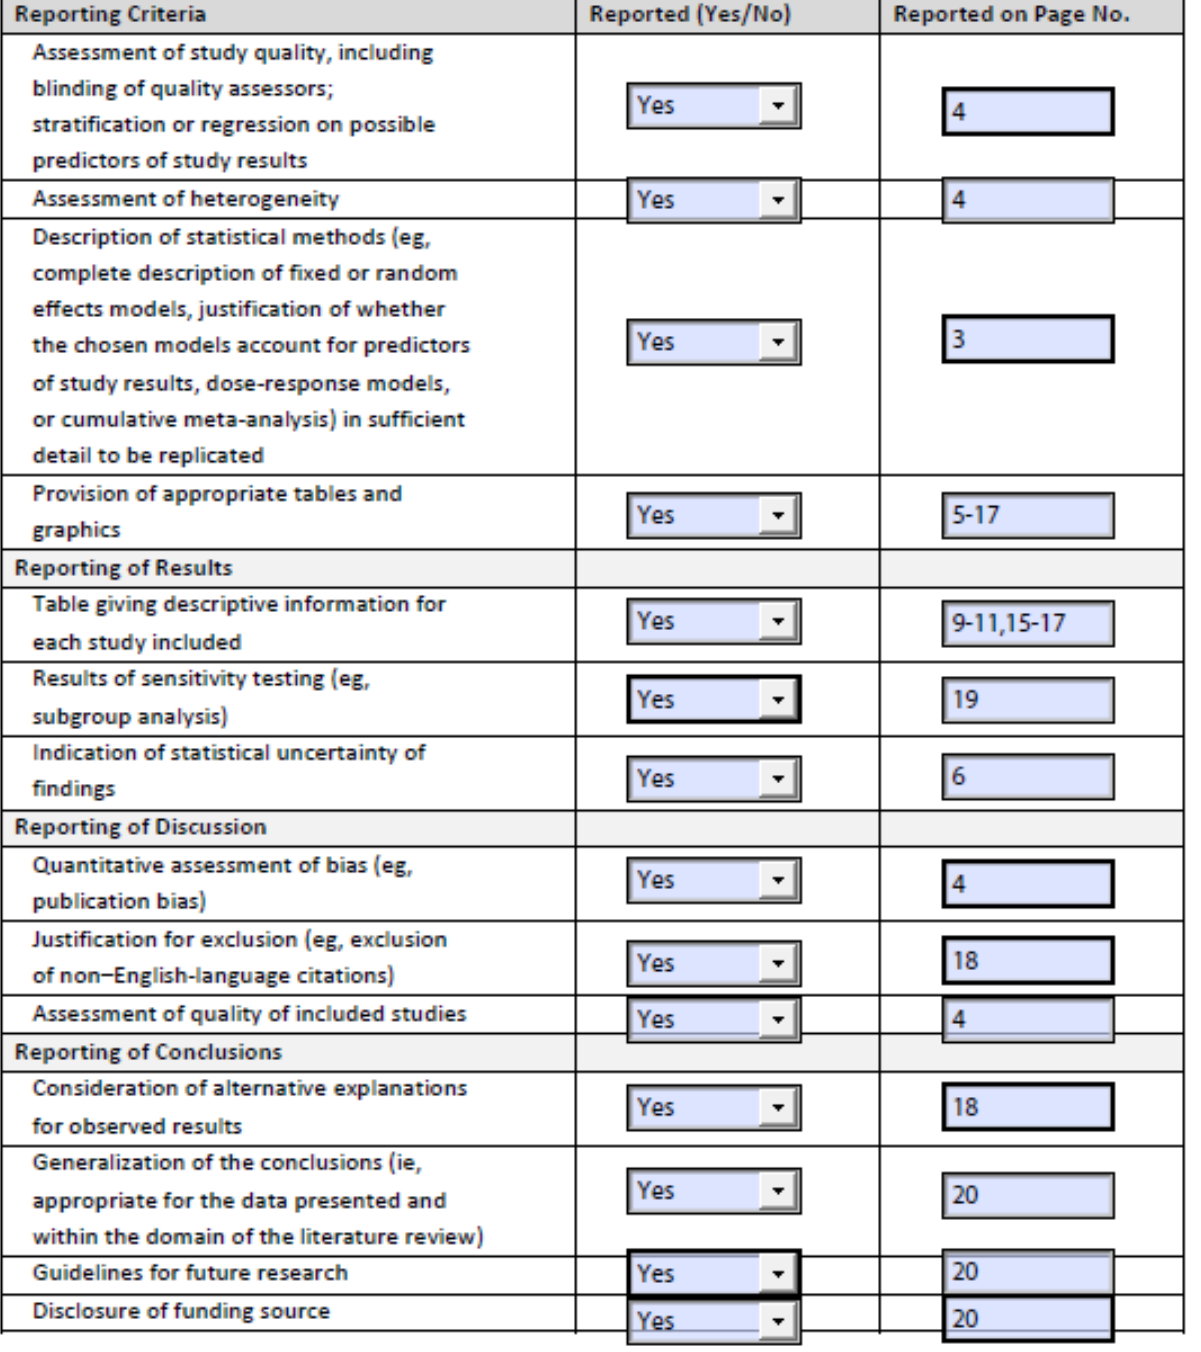
Figure A1. MOOSE (Meta-Analysis of Observational Studies in Epidemiology) checklist.